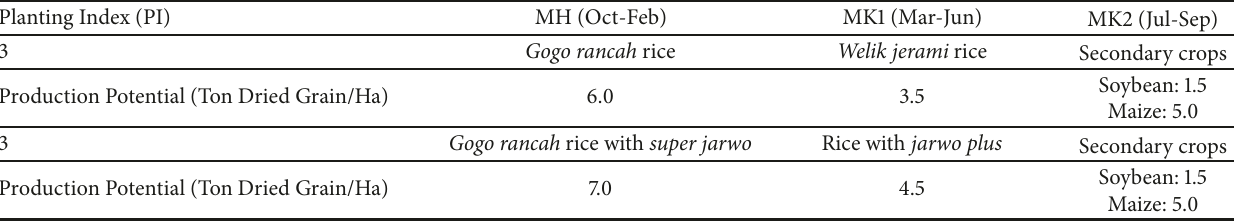
Table 2: Comparison of yield from annual cropping pattern in rain-fed land.